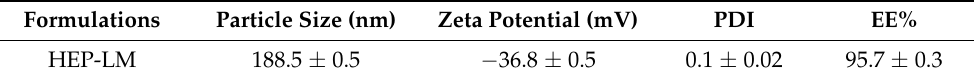
EE%, encapsulation